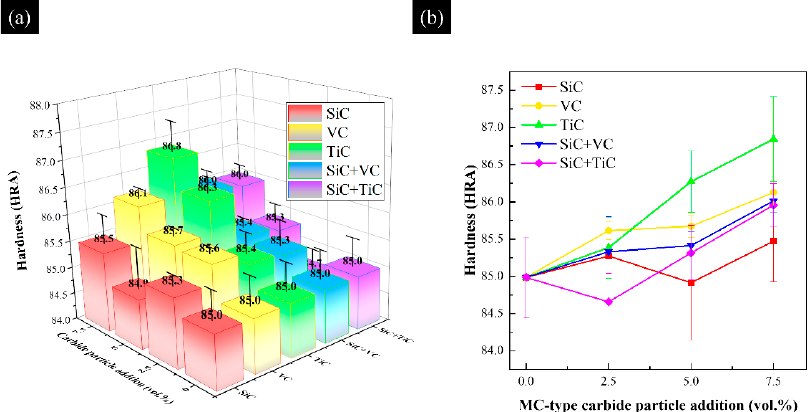
Figure 8. The effect of the volume fraction and type of additive MC-type carbides on the room- temperature hardness of designed MMCs. ( a ) Histograms of hardness vs. volume fraction and type of carbides; ( b ) Curve of hardness vs. MC-type carbides addition.